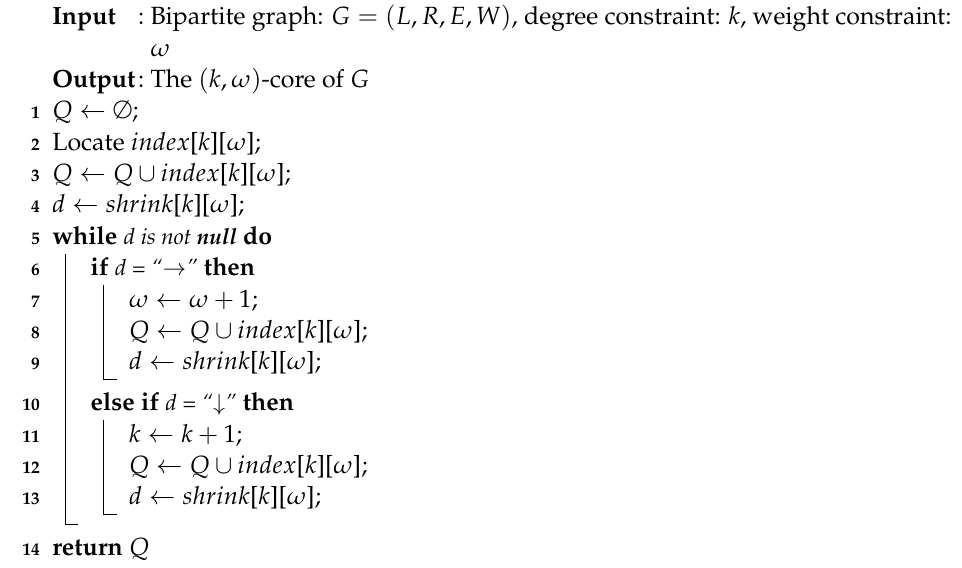
Algorithm 4 : O PTION I NDEX BASED Q UERY A